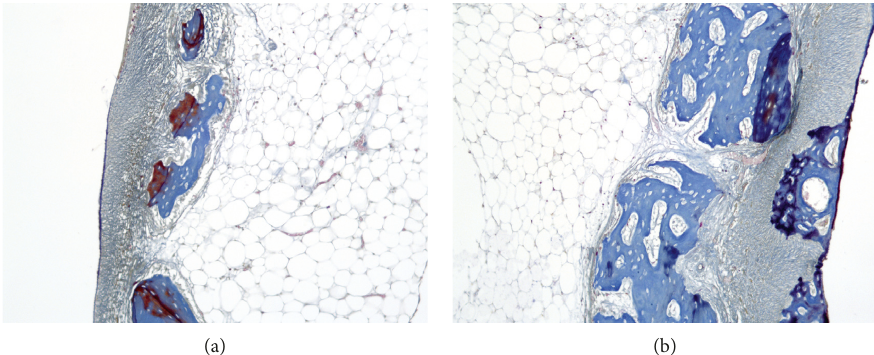
Figure 3: (a, b). Cross section of a rabbit’s jaw 2 weeks after the formation of a bone defect and introduction of calcium hydroxide suspension.